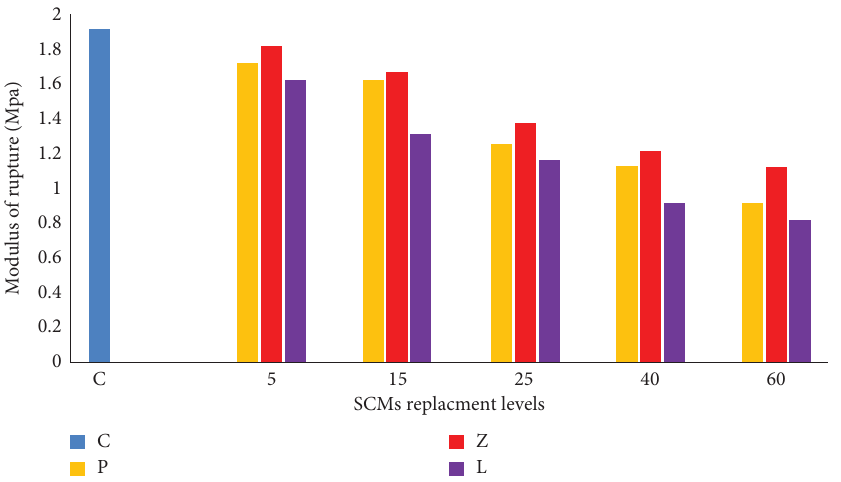
Figure 5: Modulus of rupture of the mixtures at the age of 28days.